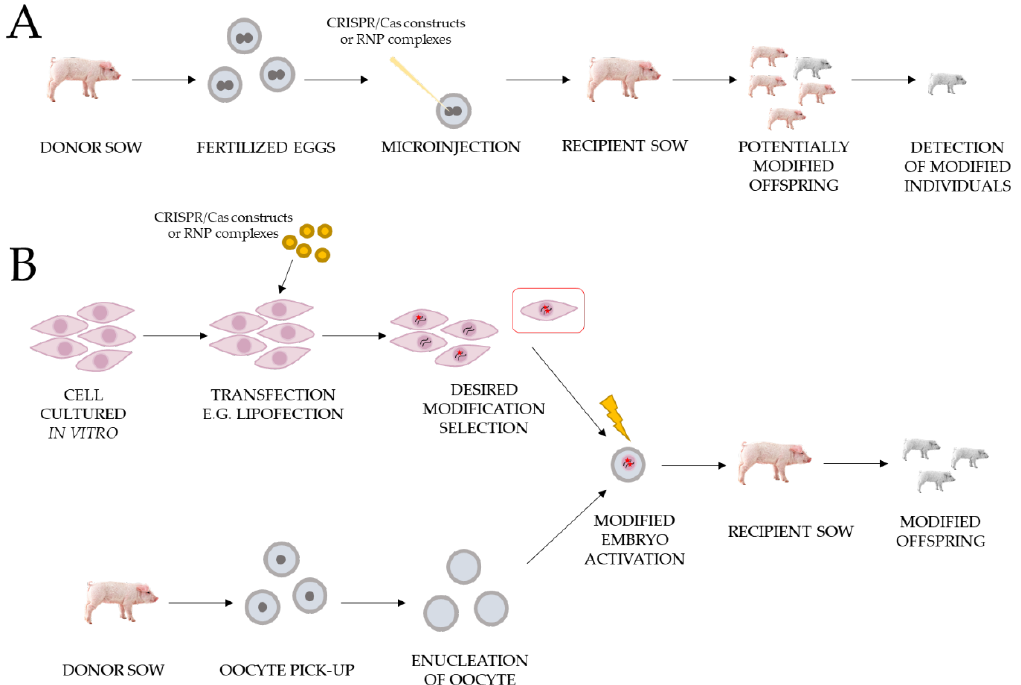
Figure 2. Workflows for obtaining gene edited pigs using the CRISPR/Cas system for xenotransplantation purposes. The figure shows two methods: ( A ) Microinjection of CRISPR/Cas modified constructs or RNPs complexes into porcine zygotes. ( B ) Somatic cell nuclear transfer (SCNT).